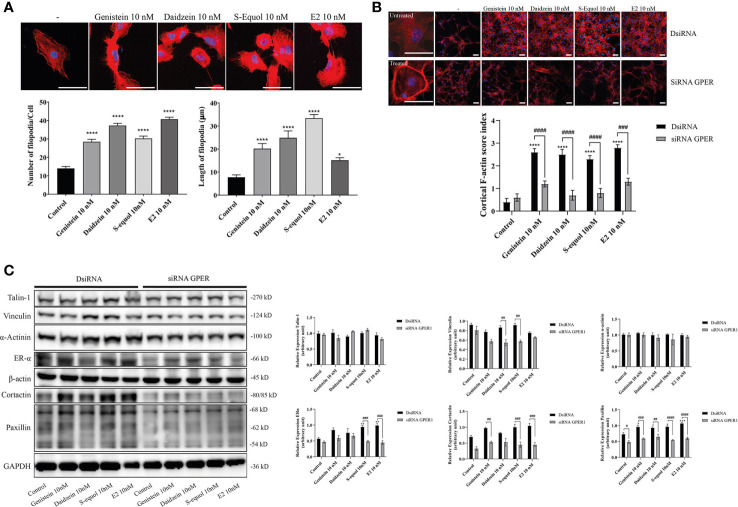
Effects of isoflavones on F-actin formation in astrocytes. Mouse primary cerebral cortex astrocytes were cultured for seven days, followed by fluorescence labeling analysis using phalloidin F-actin and DAPI. (A) Upper panel: Representative photomicrographs showing the F-actin and DAPI staining to examine the effects of isoflavones and E2 on filopodia formation. Lower panel: Changes in the number and length of filopodia. The number and length of filopodia were quantified using FiloQuant Fiji ImageJ software (NIH). (B) Upper panel: Representative photomicrographs showing F-actin and DAPI staining to examine the effects of isoflavones and E2. The first column shown the overview images with higher magnification to differentiate between the treated and untreated cells. Astrocytes were transfected with DsiRNA or siRNA of GPER, then exposed to isoflavones or E2 for 60 min after serum-starvation for 6 h. Lower panel: Changes in the cortical F-actin score index. Bars represent 50 μm. (C) Western blot analysis of talin-1, vinculin, α-actinin, ERα, β-actin, cortactin, paxillin, and GAPDH levels after 60 min exposure of isoflavones or E2 in C6 cells. Representative blots are shown in the left panel, whereas quantitative analysis results are shown in the right panel. Data are expressed as mean ± SEM and are representative of at least three independent experiments. ****p < 0.0001, ***p < 0.001, **p < 0.01, *p < 0.05, indicates statistical significance measured using Bonferroni’s test compared with control (-). ####
p < 0.0001, ###
p < 0.001, ##
p < 0.01, #
p < 0.05, indicates statistical significance measured using Bonferroni’s.